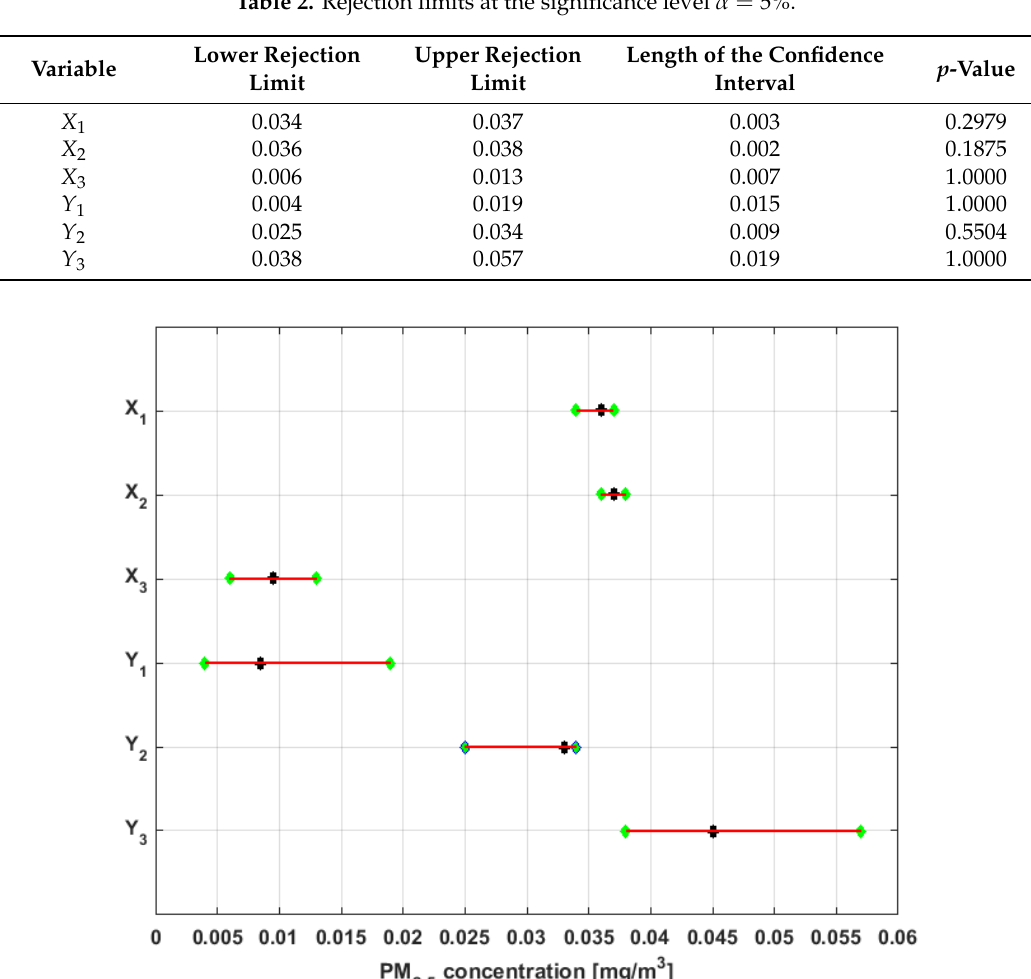
Figure 9. 95% nonparametric confidence intervals for the medians. Median: Black circle; Ends of the intervals: Green diamond.